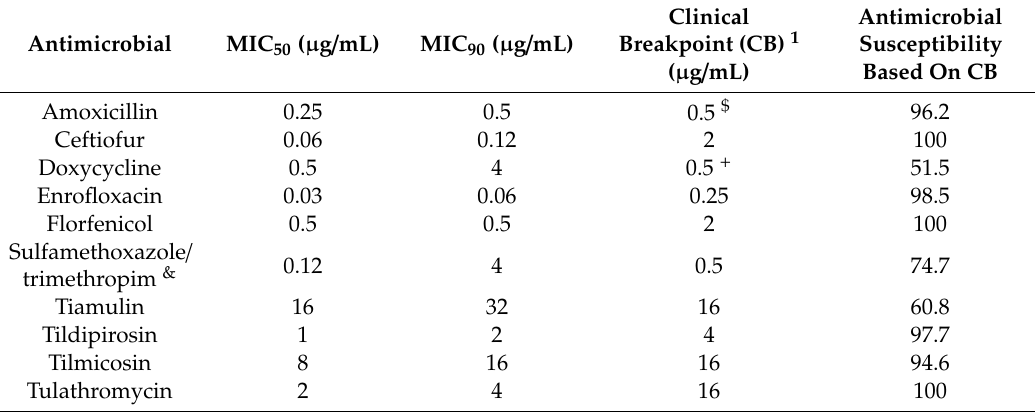
Table 3. Pasteurella multocida (PM), MIC 50 , MIC 90 , current recommended clinical breakpoints (CB) and antimicrobial susceptibility. The MIC 50 and MIC 90 were determined from the MIC distribution from 130 PM strains isolated from respiratory clinical cases. The antimicrobial susceptibility was calculated as the percentage of bacterial isolates below